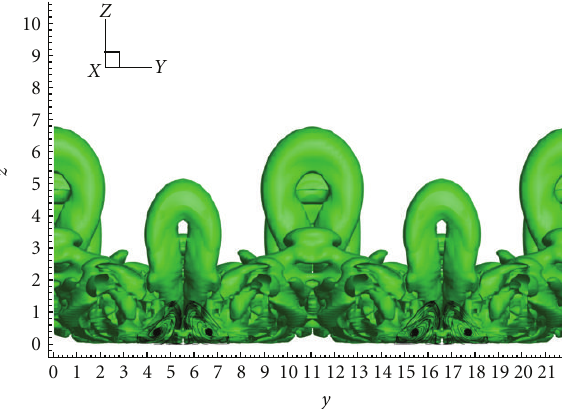
Figure 27: Velocity vector field.